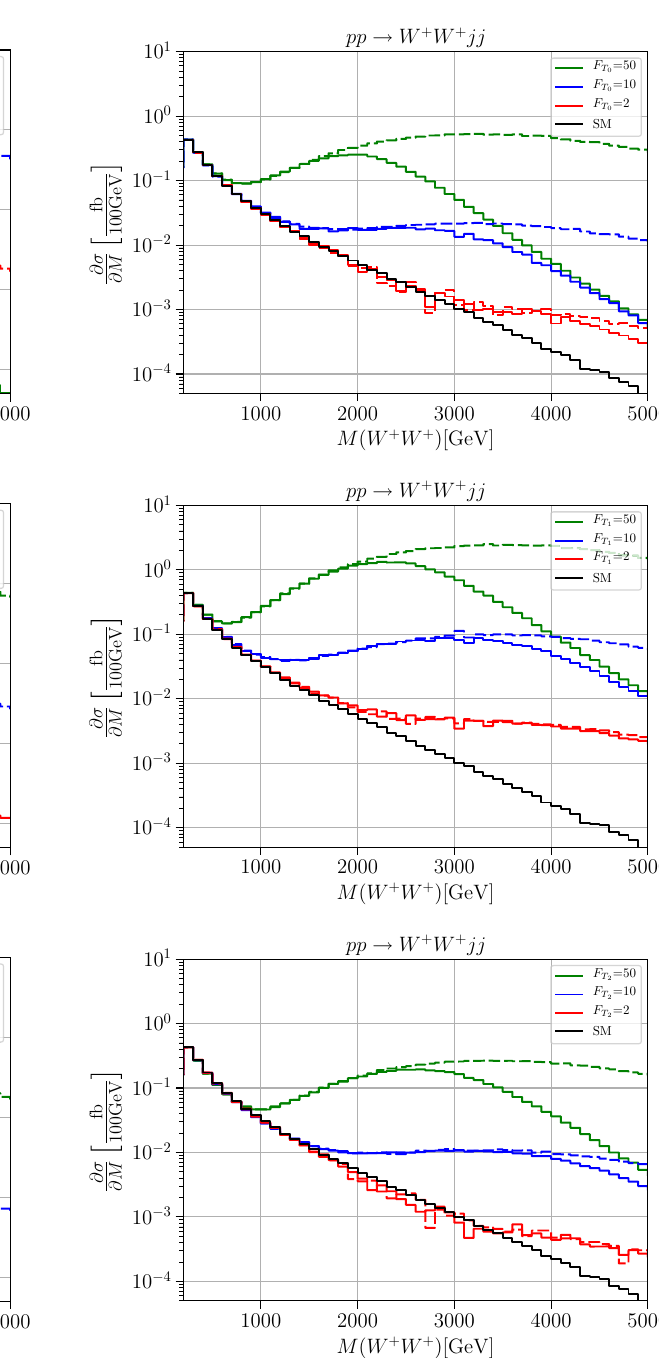
Fig. 2 Cross sections differential in the diboson invariant mass for the Fig. 3 Cross sections differential in the diboson invariant mass for process pp → H Hjj . The solid black line shows the Standard Model the process pp → W + W + jj . The solid black line shows the SM differential cross section, the green, blue and red lines the cross sections differential cross section, the green, blue and red lines the cross sections = 50 TeV − 4 , F = 10TeV − 4 and = 50 TeV − 4 , F = 10TeV − 4 and with anomalous couplings F M with anomalous couplings F T M i T i i i = 2TeV − 4 for i = 0 (upper panel), i = 1 (middle panel), and i = 7 = 2TeV − 4 for i = 0 (upper panel), i = 1 (middle panel), and i = 2 F M F T i i (right panel), respectively. Solid: unitarized; dashed: naive result. Cuts: (lowerpanel),respectively.Solid:unitarized;dashed:naiveresult.Cuts: > 20 GeV > 20 M jj > 500 GeV, Δη jj > 2 . 4, | η j | < 4 . 5, p j M jj > 500 GeV, Δη jj > 2 . 4, | η j | < 4 . 5, p j T T